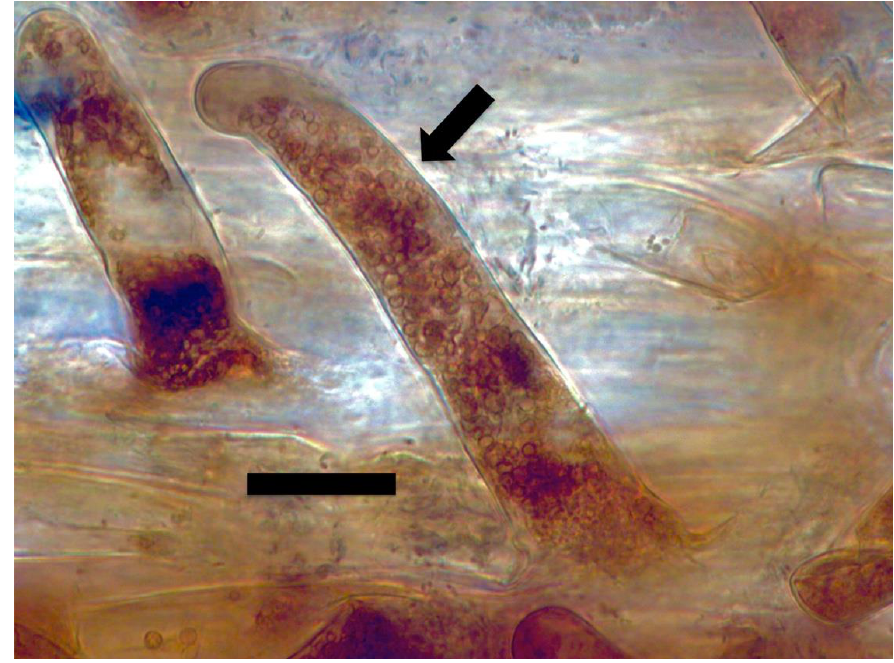
Figure 8. Dahlia pinnata seedling root hairs (arrow) stained with diaminobenzidine tetrahydrochloride (DAB) to show hydrogen peroxide (brown color) around bacterial protoplasts in hair (bar = 15 µm).